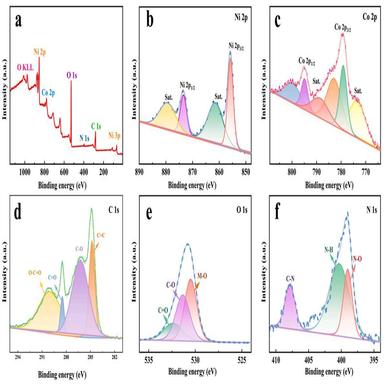
XPS spectrum of N/NC-10 (a), the high-resolution XPS spectra of Ni 2p (b), Co 2p (c), C 1s (d), O 1s and N 1s.